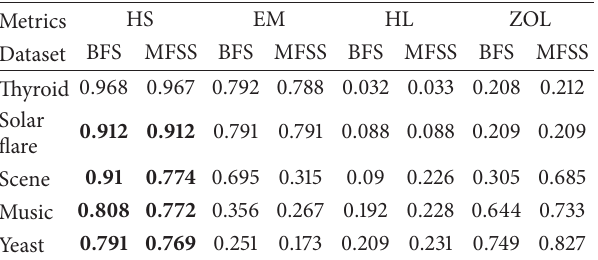
Table 4: Evaluation metrics for SVM algorithm.